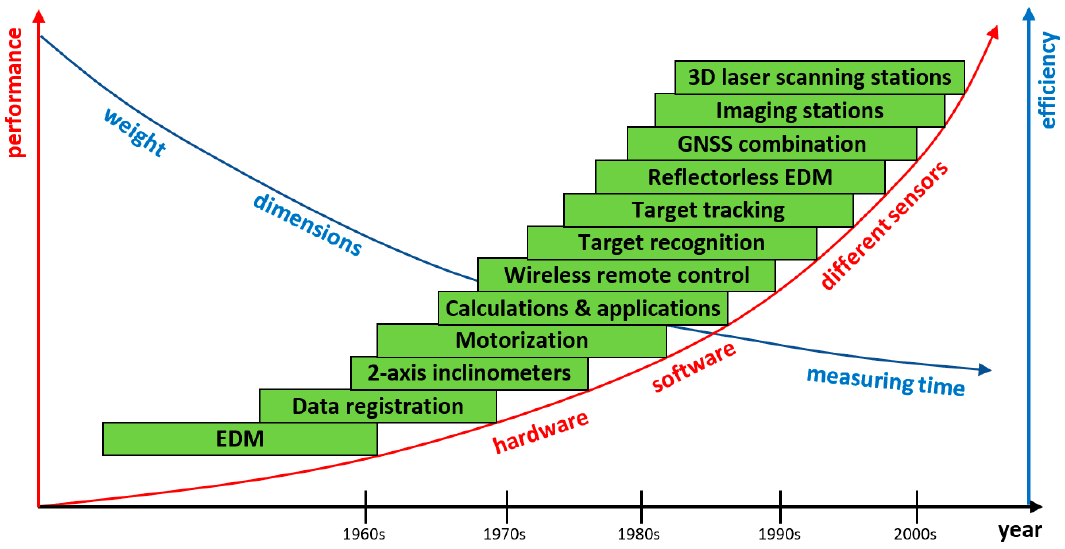
Figure 1. Total station technological development advances. Different types of motorization developed to drive instruments in horizontal and vertical motion have been specially designed and implemented in RTS to automatically search for reflectors and, later, for reflector tracking. Most commonly, RTS are used for highly precise measurements such as displacements and deformation monitoring of civil engineering structures and the Earth’s surface.